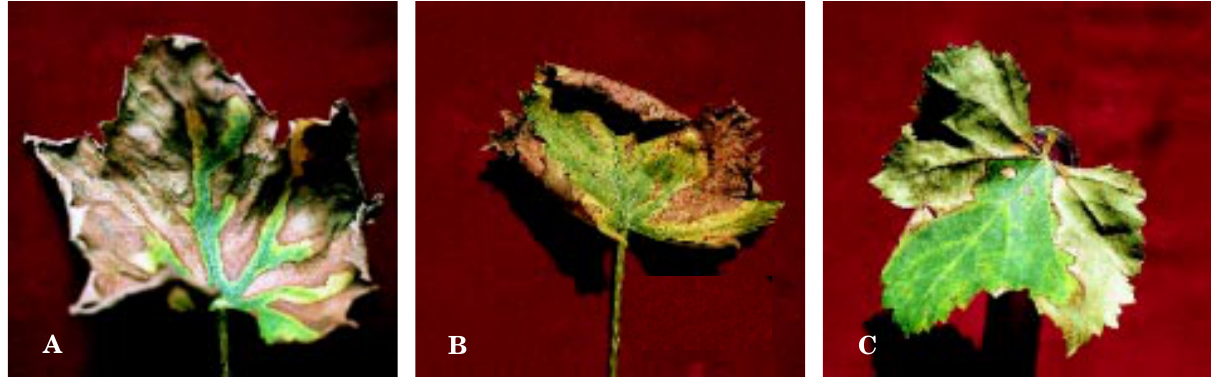
Fig. 2. Effect of the absorption for a few hours of 0.5 mg ml -1 crude extract from filtrates of 28-day-old culture of: A. P. chlamydosporum ; B. P. aleophilum ; C. F. punctata on detached leaves of grapevine cv.